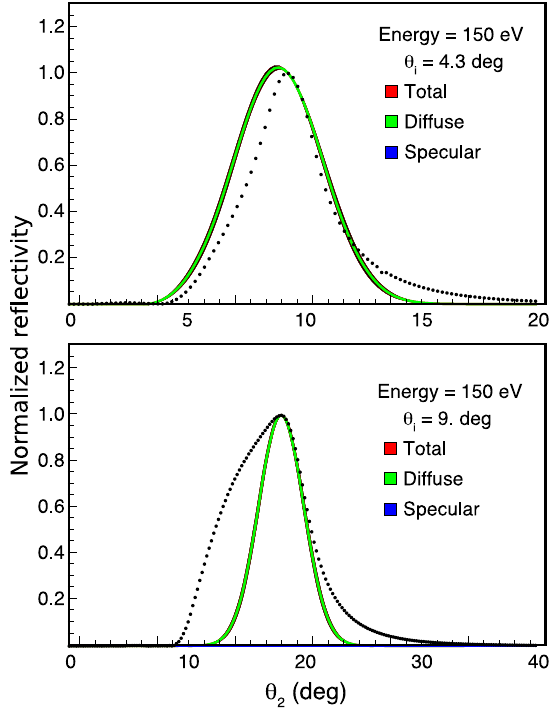
FIG. 27. Data sets Th7-Th8: Comparison between measure- ment and X-ray scattering model, θ 2 scans, for θ 1 ¼ 5 ° and θ ¼ 10 °, and 150 eV. The gray band represents the mean- 1 prediction 95% confidence level associated with the fit. The relationship between θ and θ 1 is given in Sec. i